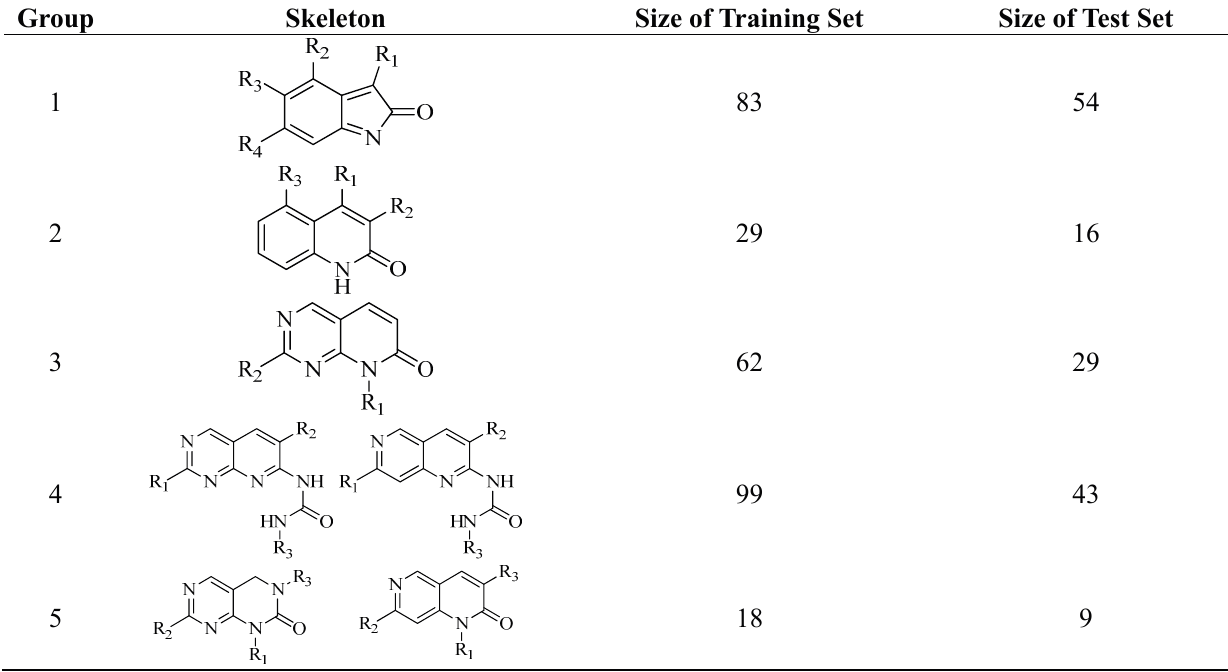
Table 5. Skeletons and number of molecules in training set and test set of each group. Group Skeleton Size of Training Set Size of Test